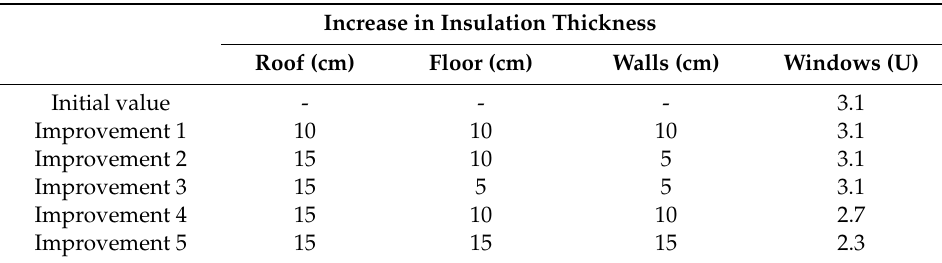
Table 4. Energy-saving improvements studied.